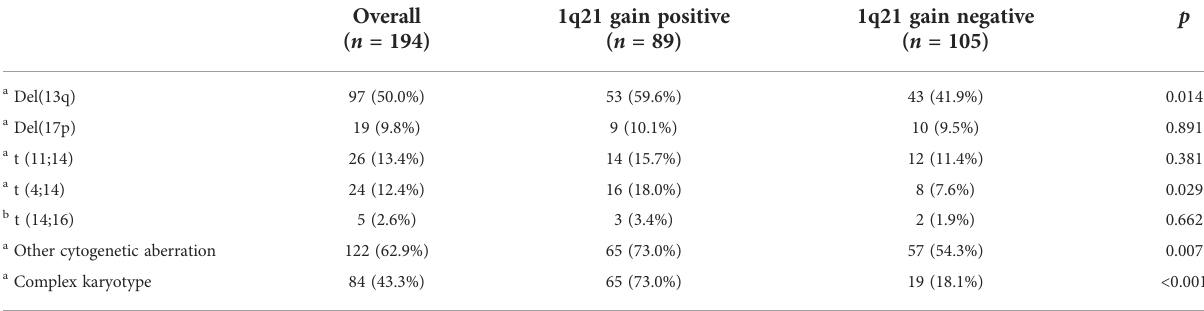
TABLE 3 Associations between 1q21 gain subgroup and cytogenetic